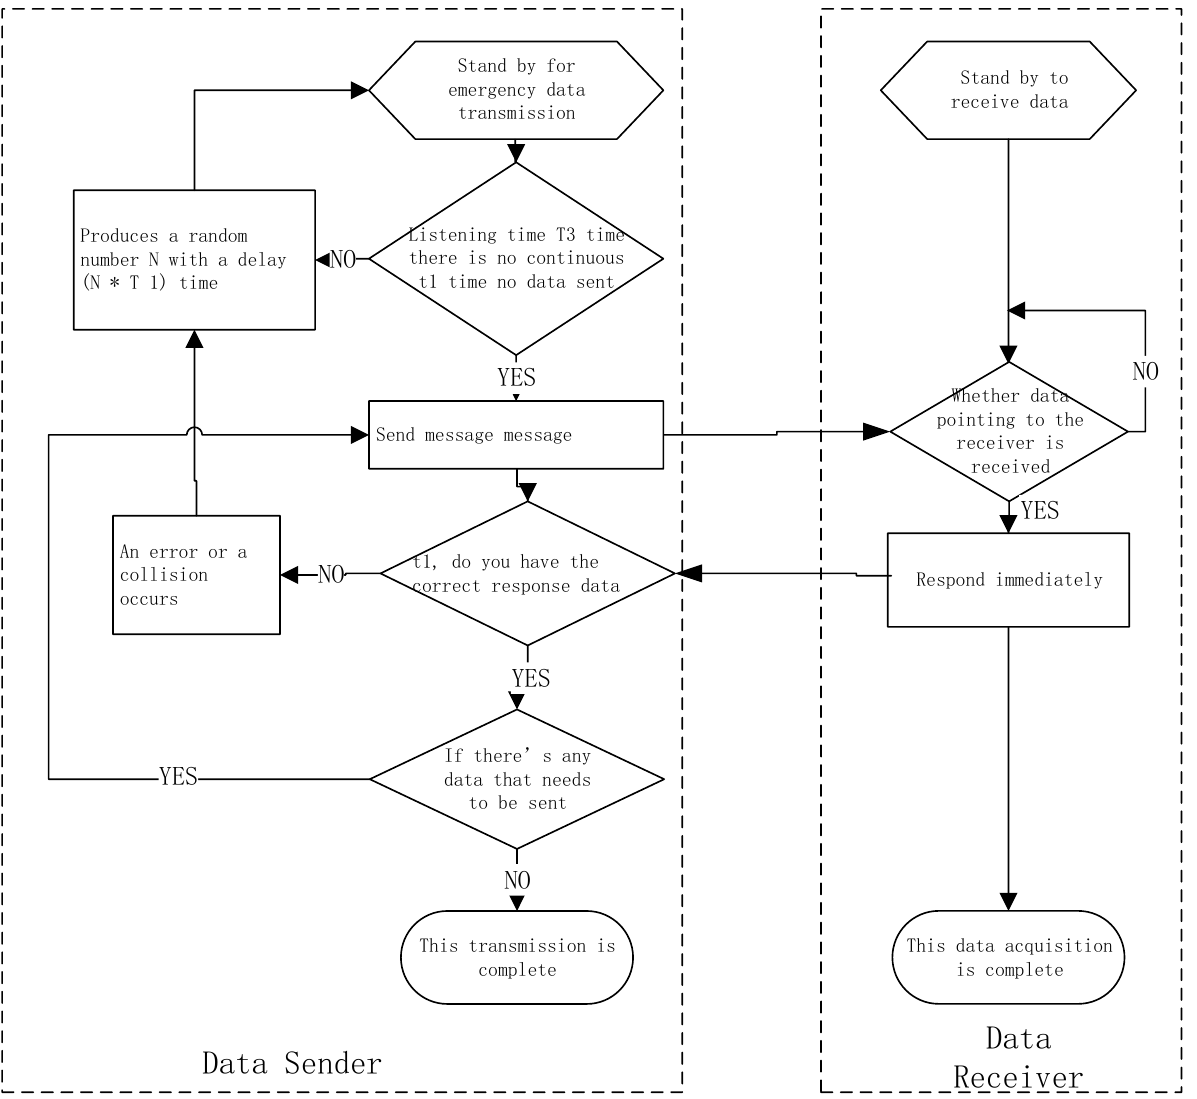
Figure 5. Module division diagram of drive